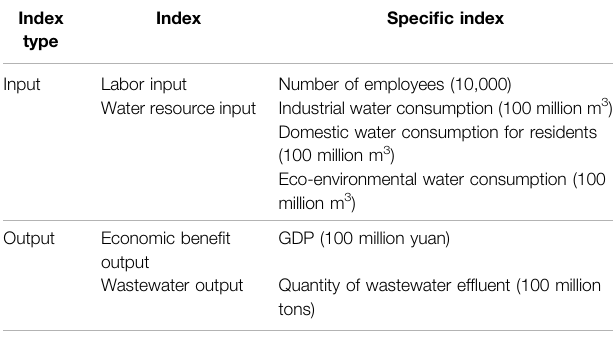
TABLE 1 | Output-input indices of water-use ef fi ciency.